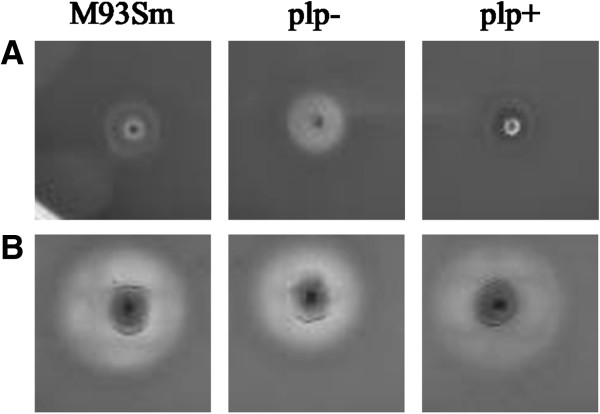
Hemolytic activity of M93Sm and S262 (plp) on TSA-sheep blood agar (A) and LB20 + 5% rainbow trout blood agar (B). A single colony of M93Sm and S262 was transferred onto each of the blood agars and incubated at 27°C for 24 h. The zones of hemolysis were measured and the diameters were given in the figure. This is a representative experiment from 3 replicate trials, each performed in triplicate.